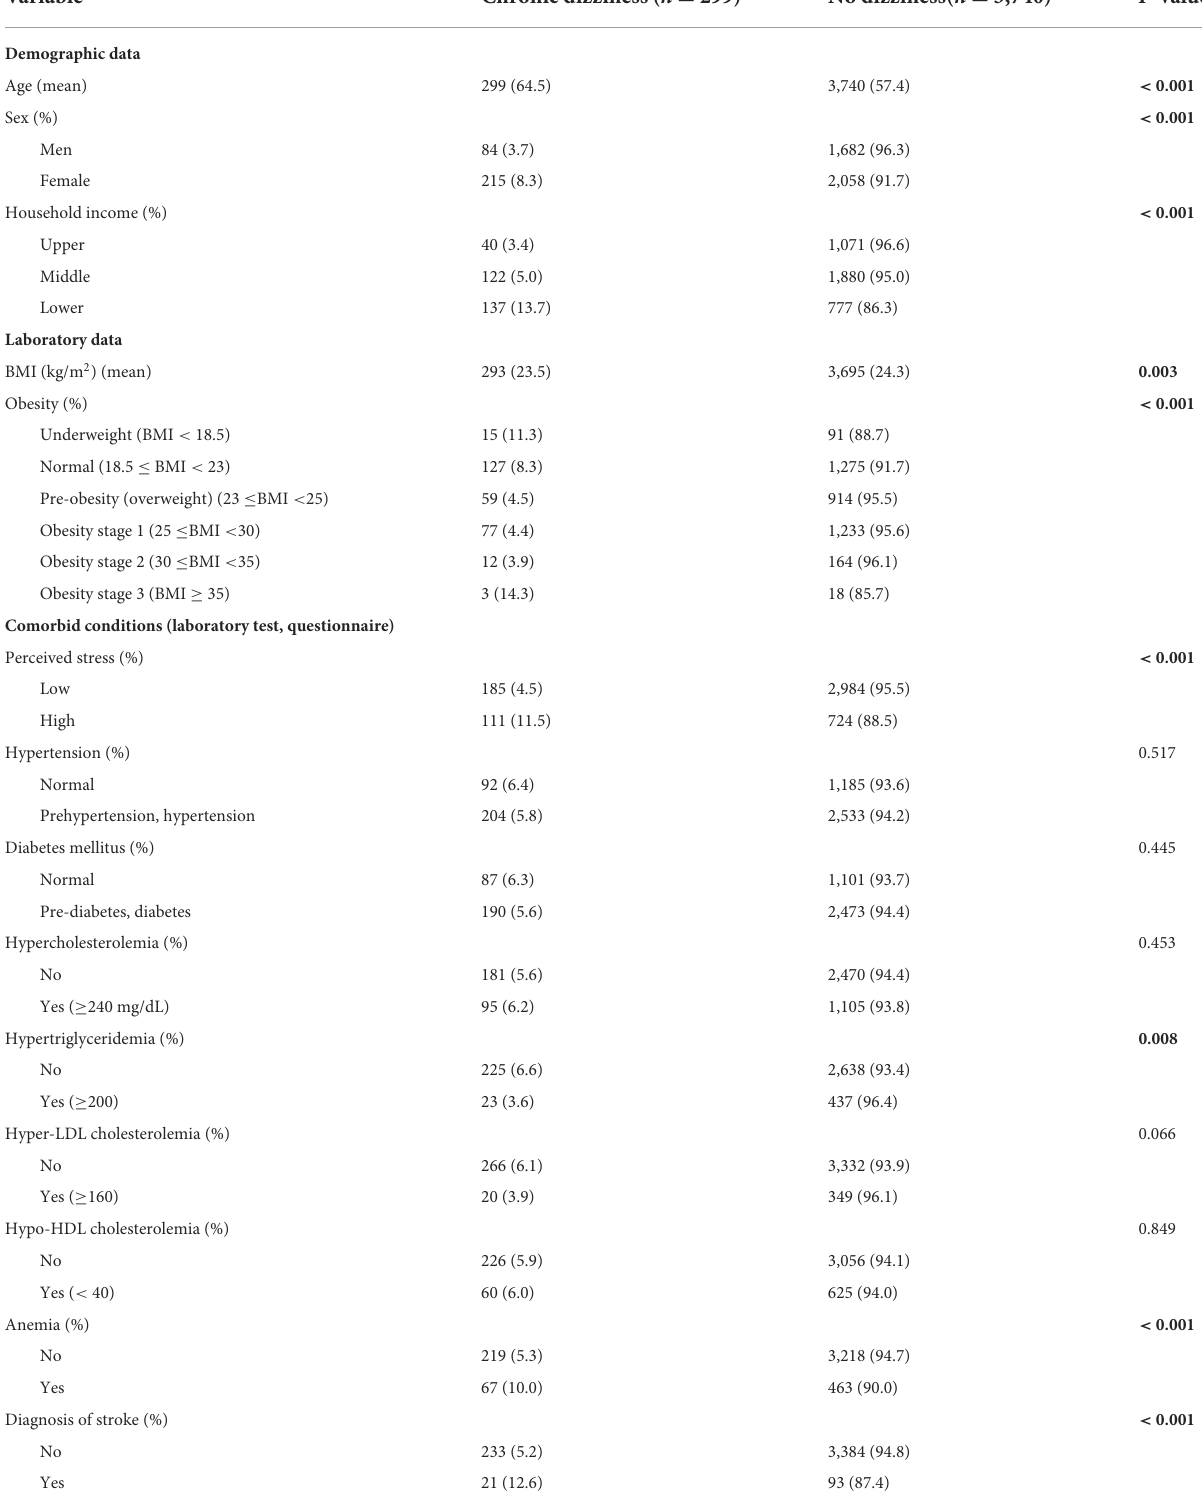
TABLE 3 Clinical characteristics by the presence of chronic